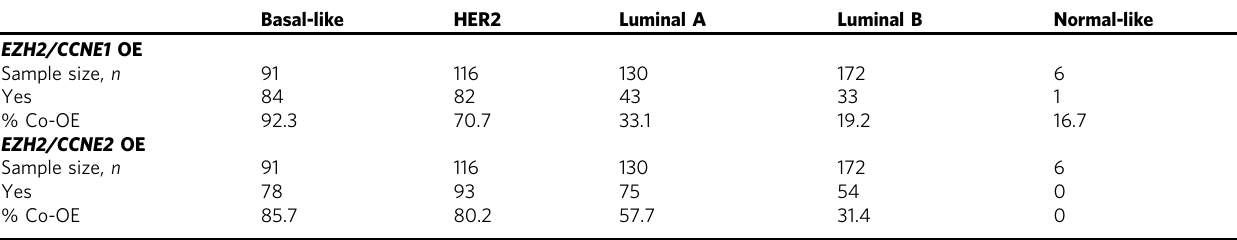
Table 3 Co-overexpression of EZH2 and cyclin E genes in breast cancers Basal-like HER2 Luminal A Luminal B